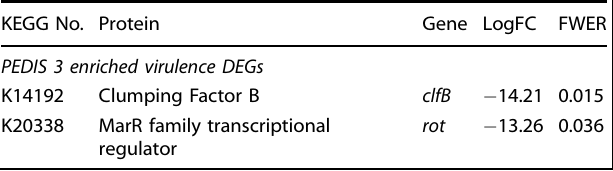
Fig. 3 Functional analysis of annotations isolated by the keyword “ virulence ” . a Bar chart showing the top 10 taxa by with virulence annotations. Annotations were extracted using the “ subsetTax ” tool included with the SQMtools R package. Patients 16 and 11 had no annotations related to “ virulence ” within these samples. b Heat map of the top ten most enriched virulence proteins across all PEDIS infection severities. Read counts were normalized prior to applying a multilevel analysis (ANOVA) fi tting all contrasts between groups to identify the top ten enriched genes. Patients are grouped by infection severity (PEDIS) with features clustered using Ward clustering. Table 1. Summary of the top enriched or depleted microbial virulence DEGs in PEDIS 4 compared to PEDIS 3 diabetic foot infections (logFC, FWER<